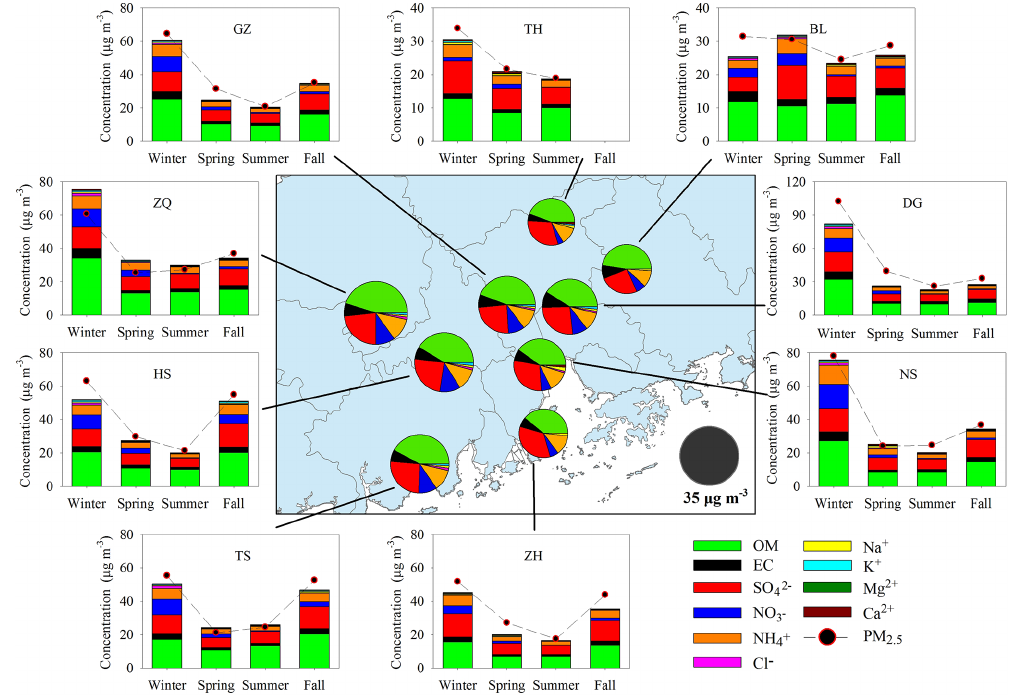
Figure 2. Major components in PM 2 . 5 and their seasonal variation at nine sites. The pie charts in the central panel represent the annual average of the major components. High levels of PM 2 . 5 and major components were observed in